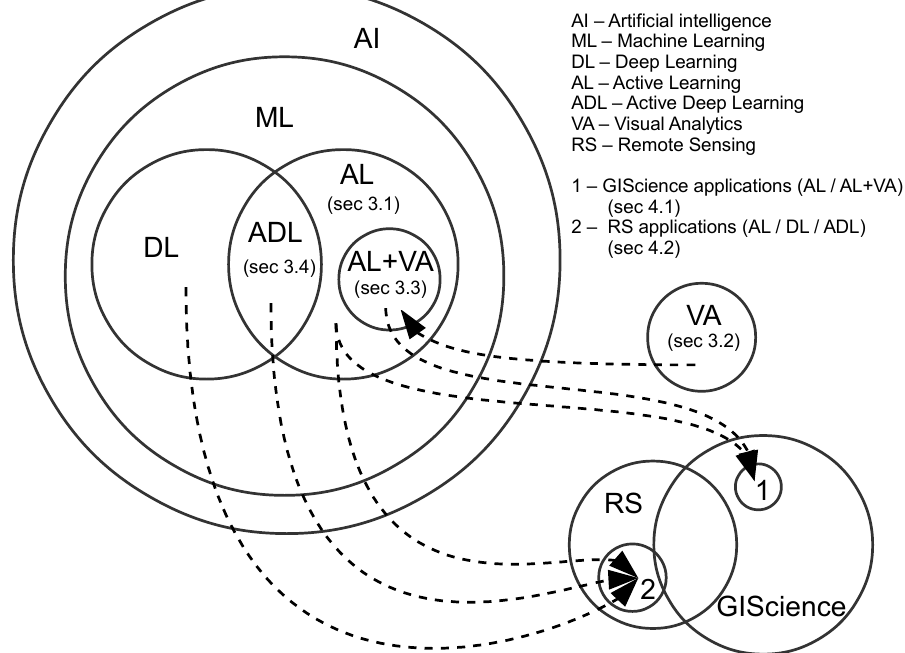
Figure 1. An overview of the review flow and the links between different research domains—the dashed lines indicate the flows among the (interdisciplinary) domains. An introduction to